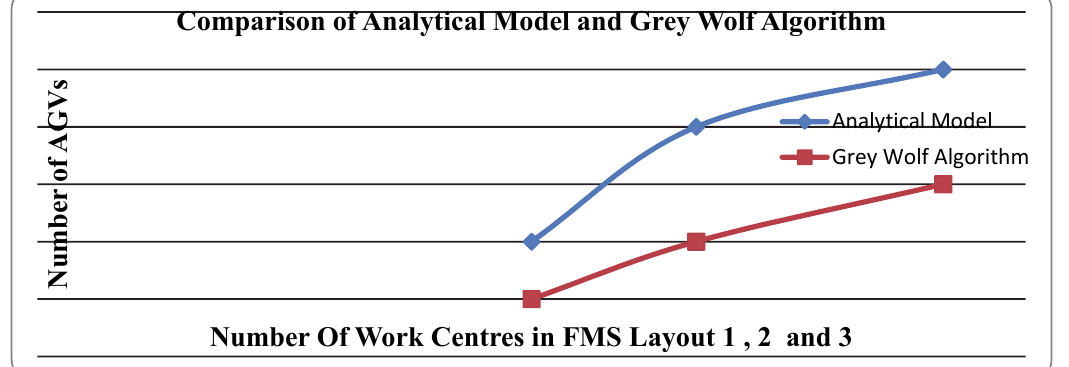
Fig. 6. Comparison of analytical and grey wolf optimization algorithm for different FMS